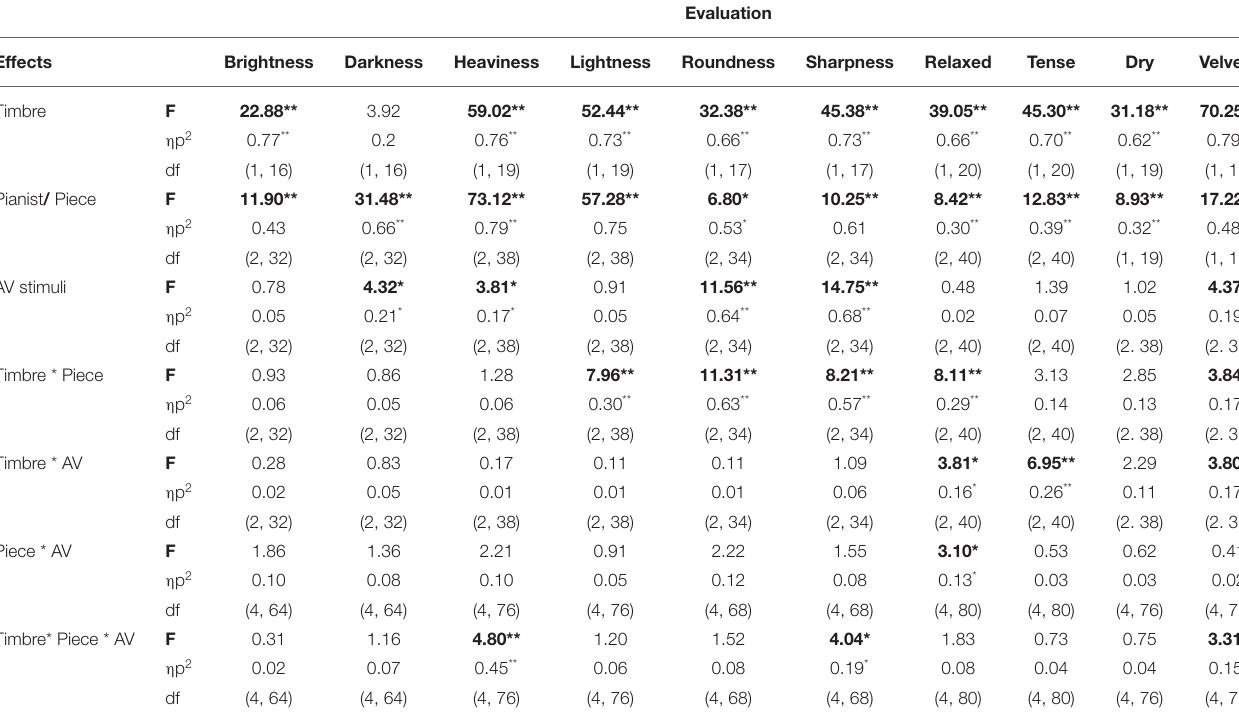
TABLE 4 | Three-way repeated measures ANOVA main effects and interactions for listeners’ evaluation of 10